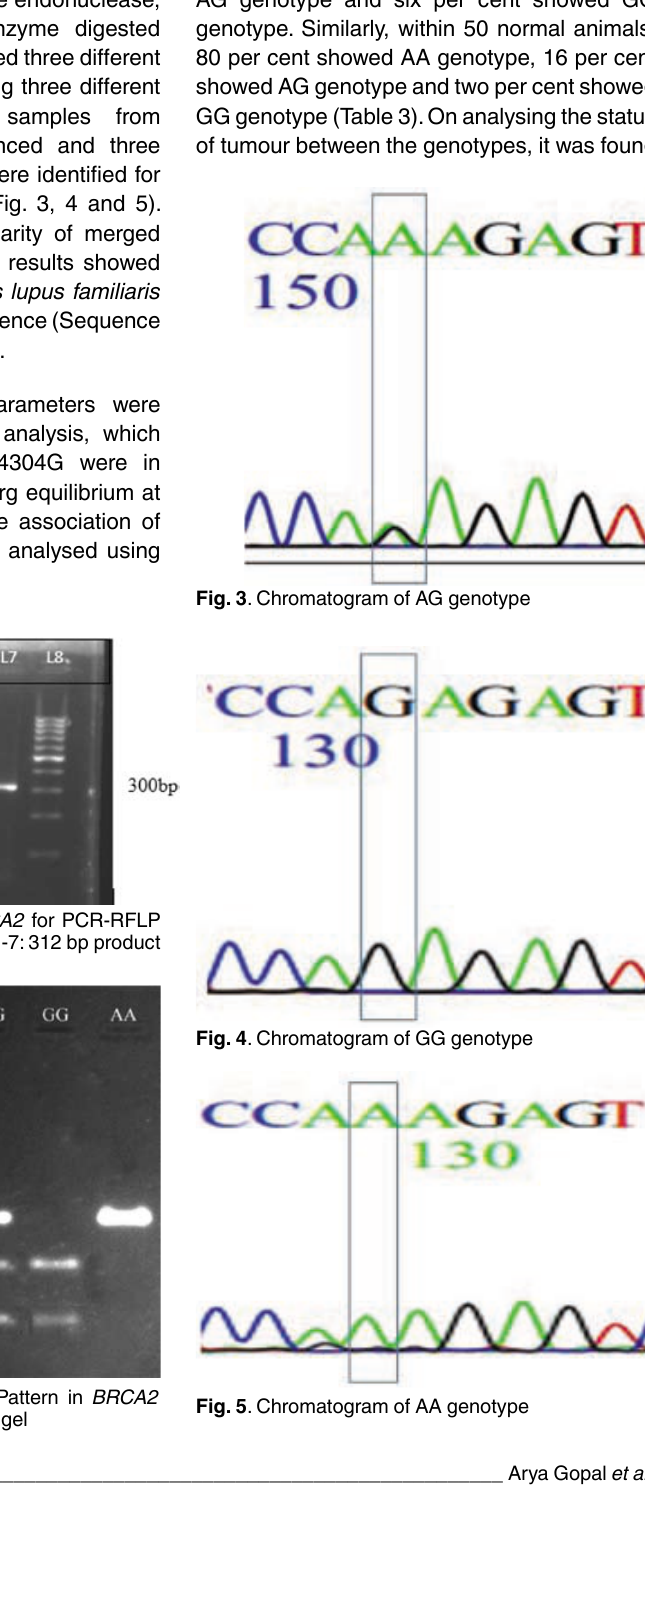
Fig. 2 . PCR product and RFLP Pattern in BRCA2 resolved in three per cent agarose gel